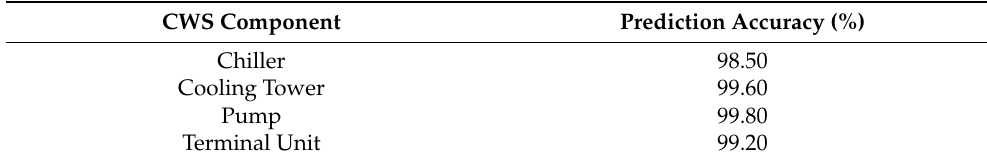
Table 8. CWS Component Prediction Accuracies.